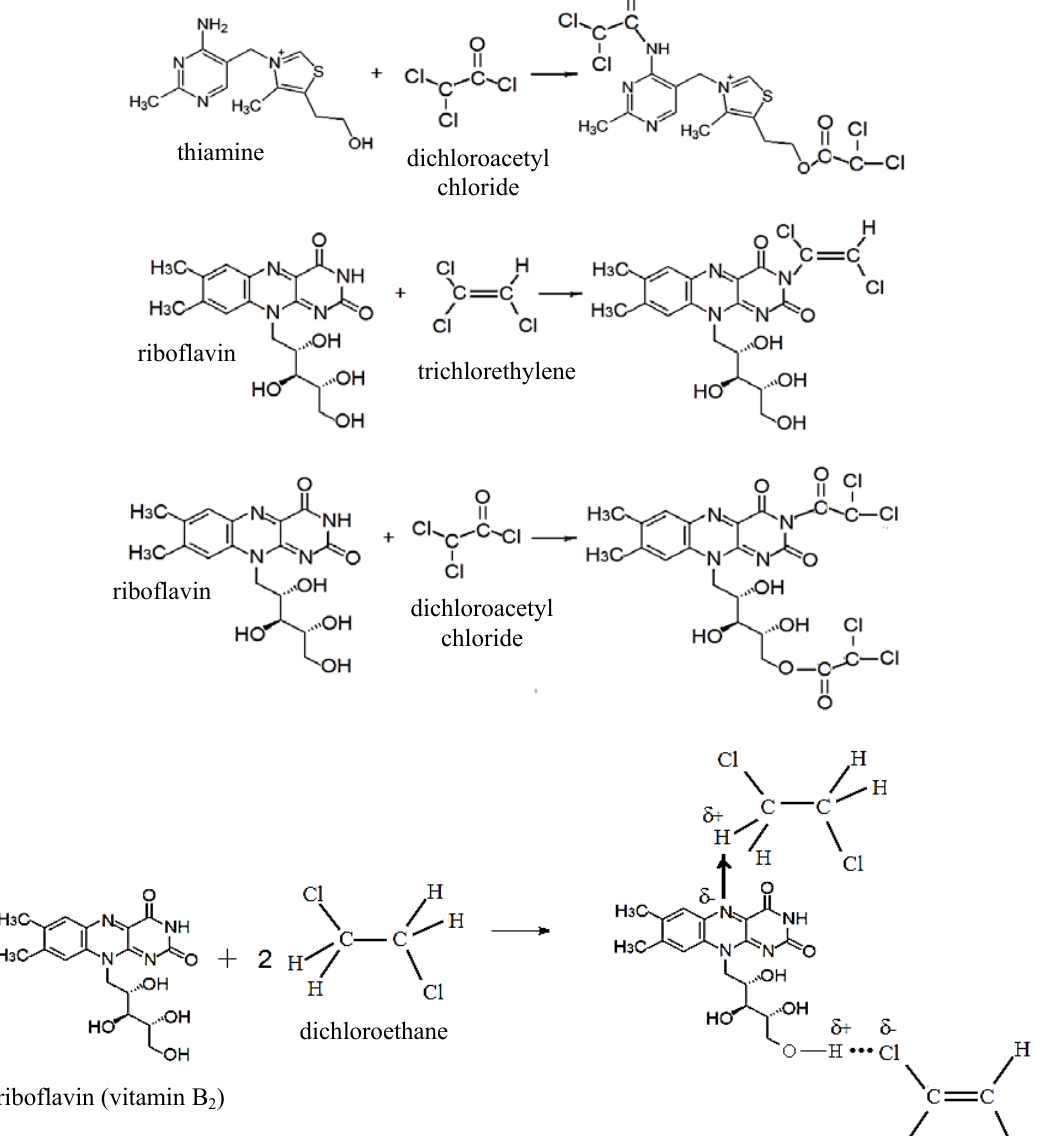
Fig. 15. Chemical interaction of vitamin B 2 with the priority contaminants contained in